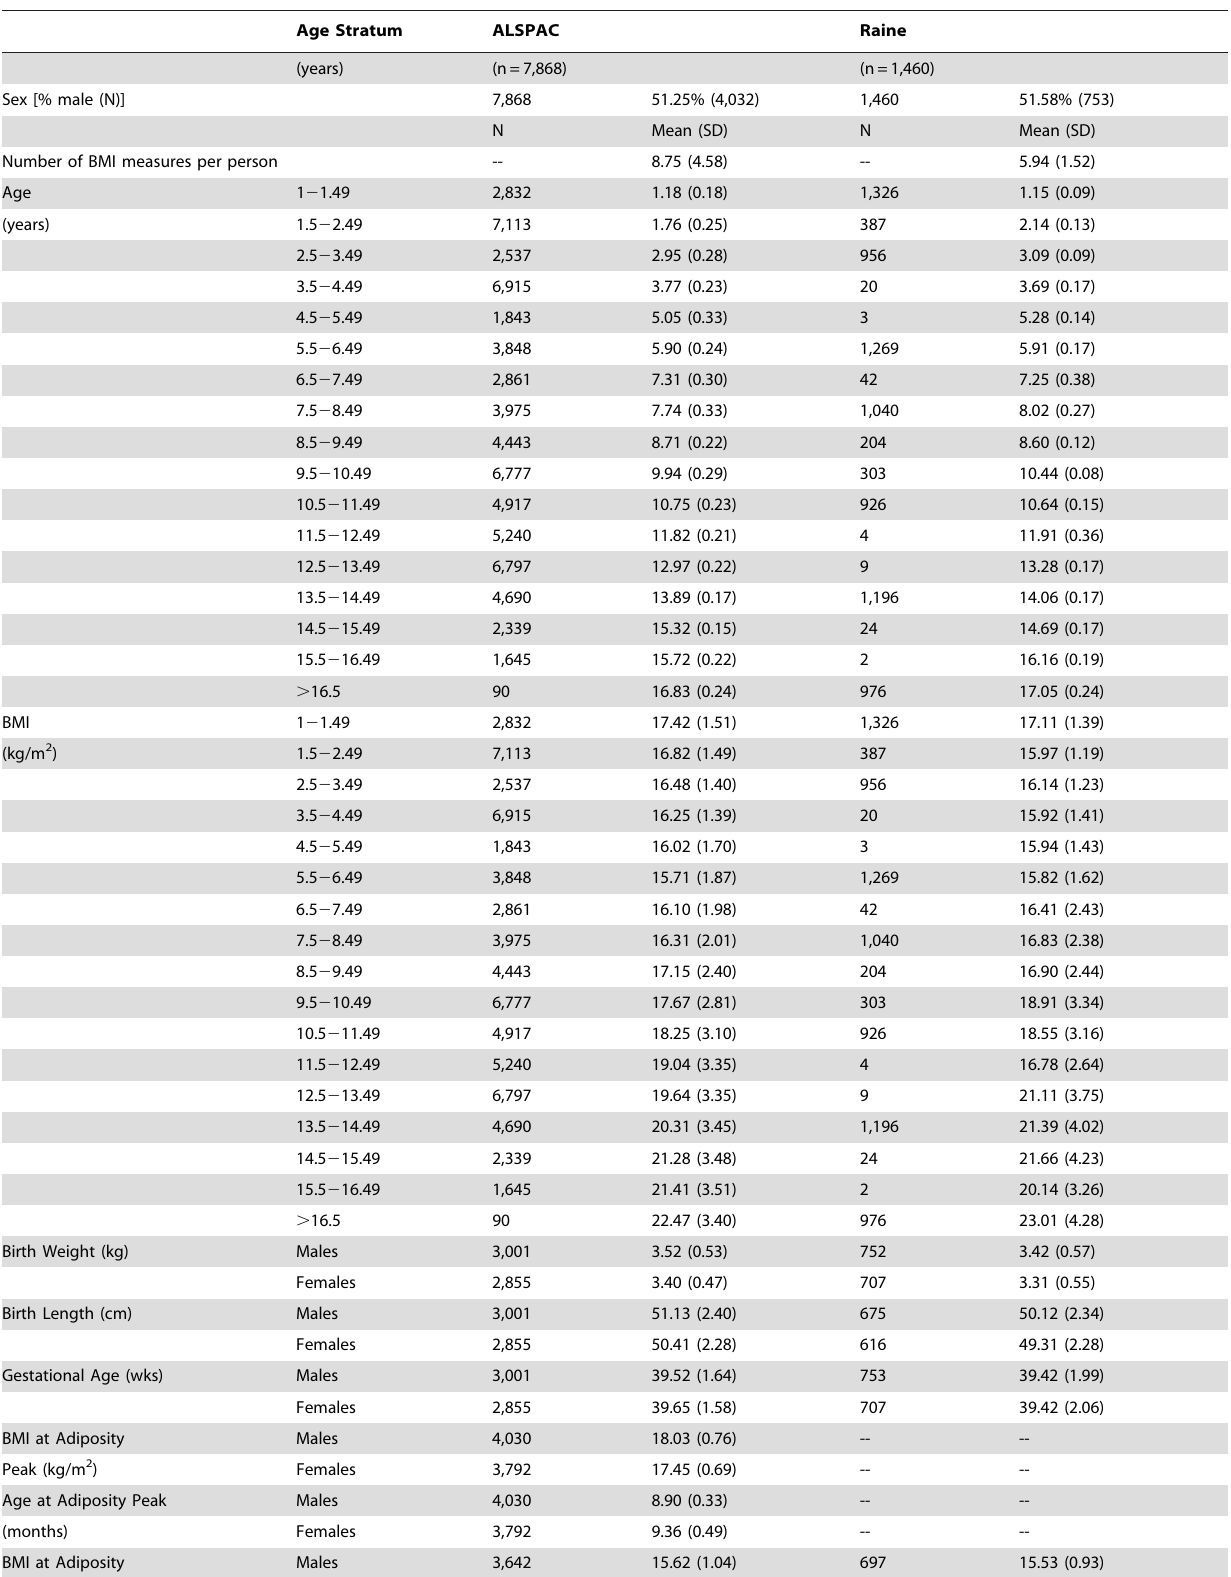
Table 1. Phenotypic characteristics of the two birth cohorts used for analysis.